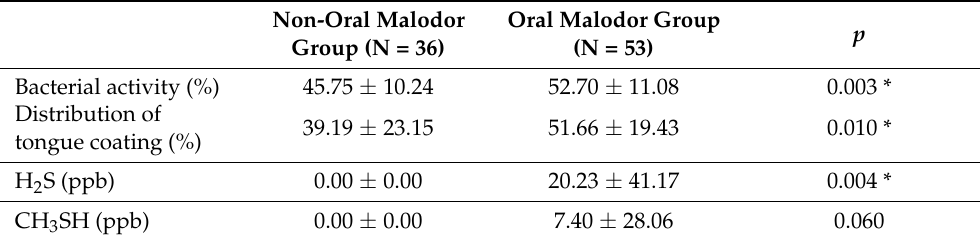
Table 3. Comparison of bacterial activity, the distribution of tongue coating, and VSCs in the non-oral malodor group and oral malodor group.